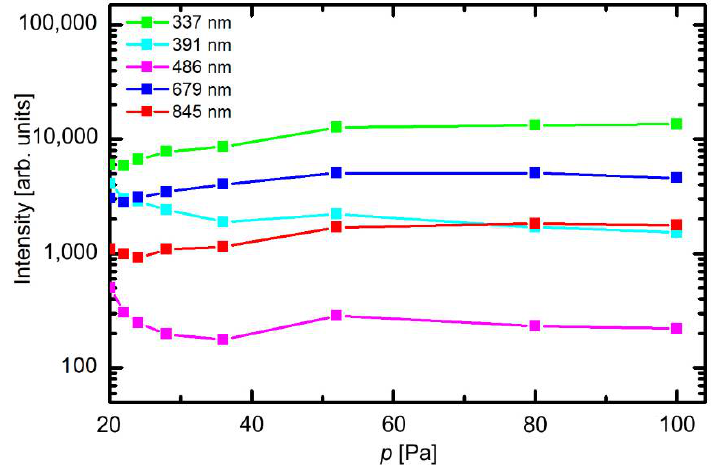
Figure 3. Intensity of selected spectral features versus pressure ( p ) in the discharge chamber.